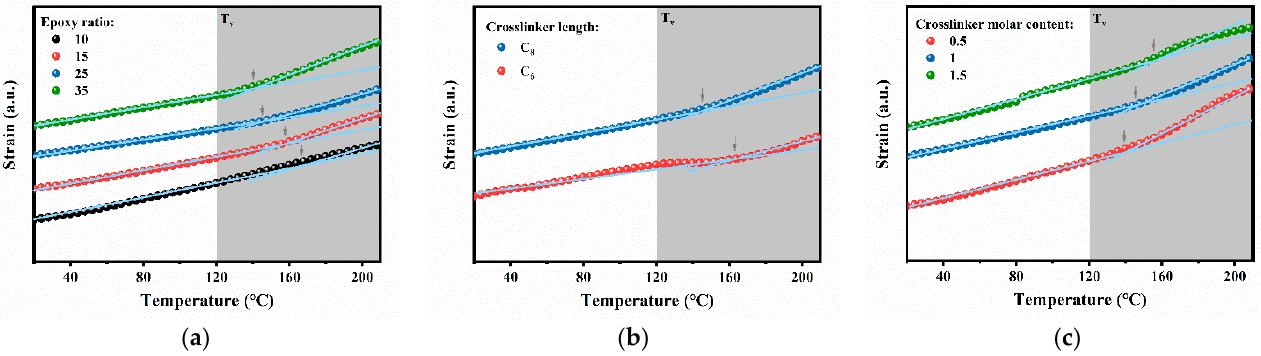
Figure 7. Thermodilatometry curves for PB vitrimers with the modification of network parameters: ( a ) epoxy ratio, ( b ) crosslinker length, and ( c ) crosslinker molar content.